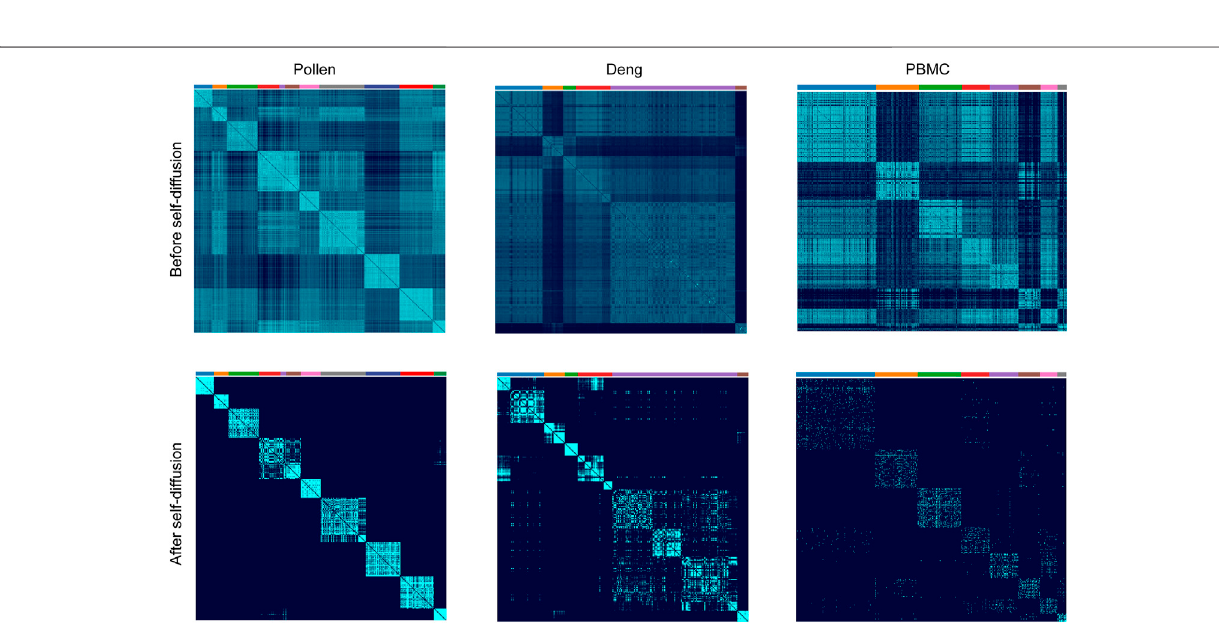
Frontiers in Genetics |